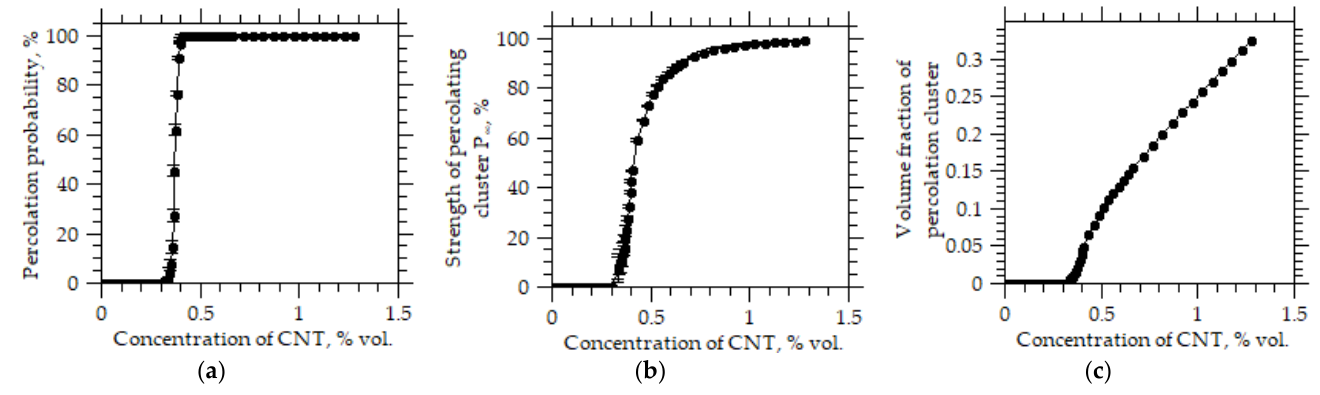
Figure 3. ( a ) Probability of formation of a percolation cluster ( b ) Strength of a percolation cluster ( c ) volume fraction of a percolation cluster from the volume concentration of CNTs. Table 2. Experimental and calculated gas permeability coefficients and Knudsen diffusion coeffi- cient for the studied gases.